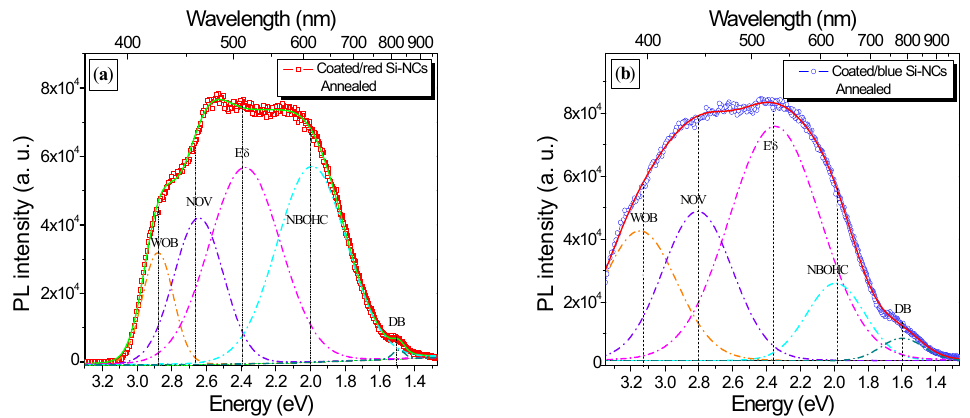
Figure 8. (Color Online) PL emission of coated films with red ( a ) and blue ( b ) Si-NCs after annealing at 1100 °C in N 2 . Compared to Figure 7, these spectra are wider, and both shift towards the blue-green region of the visible spectrum.